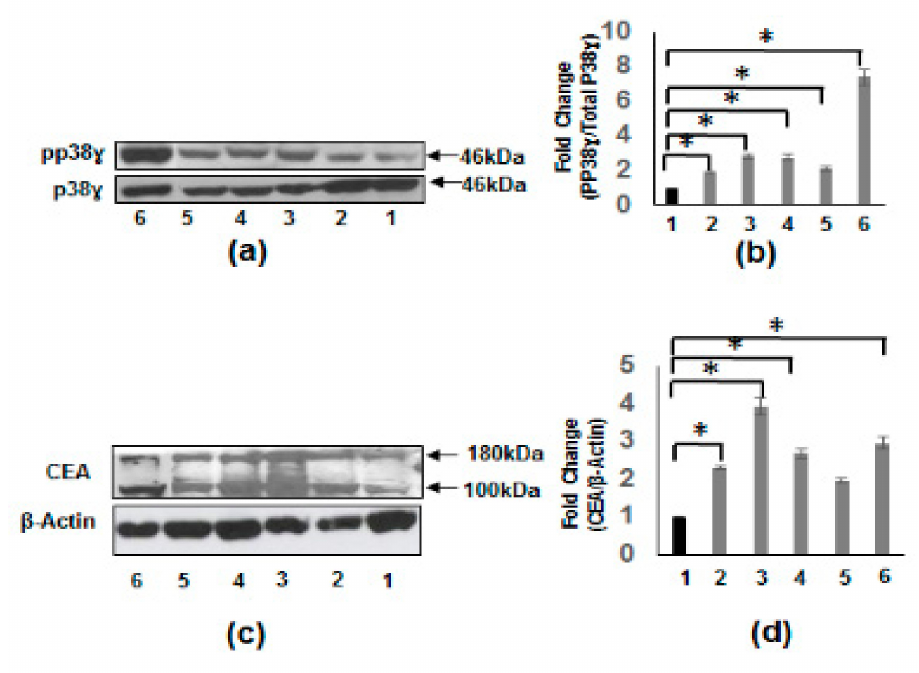
Figure4. Increasedphosphorylationofp38 γ andproteinexpressionofCEAinCRCcelllines. ( a )Western blot using specific antibodies to p38 γ and pp38 γ in cell extracts from IEC-6 rat intestinal epithelial cells (lane 1), HCT 116 human CRC cells (lane 2), HT-29 human CRC cells (lane 3), Caco-2 human CRC cells (lane 4), SW620 human CRC cell line (lane 5), and HepG2 human hepatoblastoma carcinoma cell line (lane 6). ( b ) Densitometric values expressed as fold increase of the ratio of pp38 γ / p38 γ mean ± SEM ( n = 4) * p -value < 0.05. The above results show the increased phosphorylation in CRC cell lines and HepG2 cells compared to normal IEC-6 cells. ( c ) Whole cell extracts from di ff erent cell lines were subjected to Western blotting with specific antibodies to CEA. ( d ) Densitometric values showing the fold increase of the ratio of CEA / β -actin mean ± SEM ( n = 4) * p -value < 0.05. As shown in (c) the CEA levels are uniformly increased in colon cancer cell lines and HepG2 cell